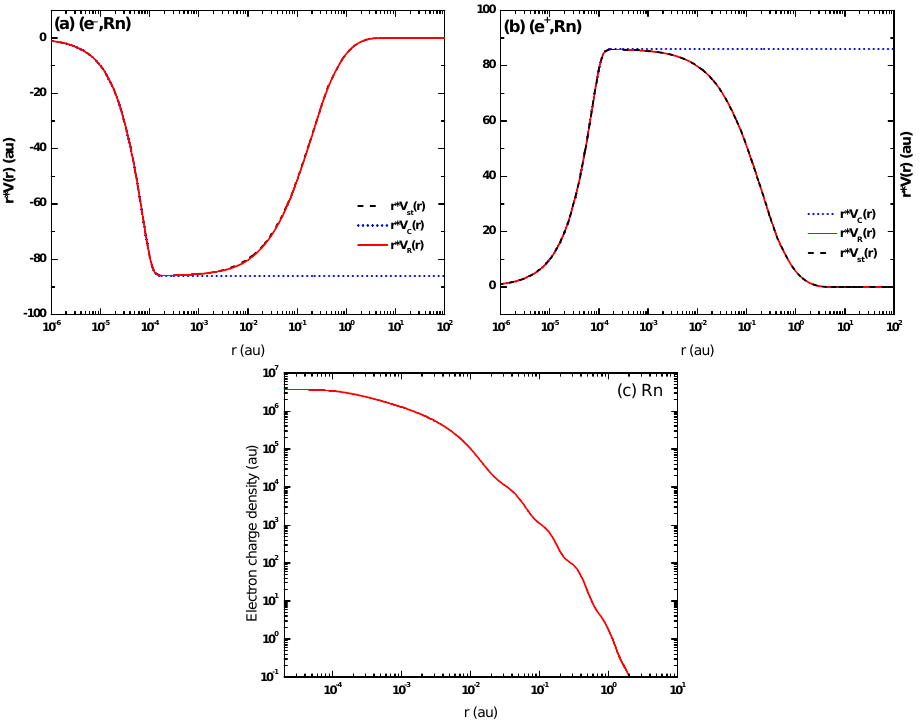
Figure 1. Potentials (multiplied by r ) for electrons ( a ) and positrons ( b ) as a function of distance r from the nucleus. Shown are the real part V R (——, red) and its static part V st ( − − −− , black) of the short range OPM potential. The Coulomb field V c = − Z / r is also included ( · · · · · · , blue). In ( c ) shown is the r dependence of electron charge